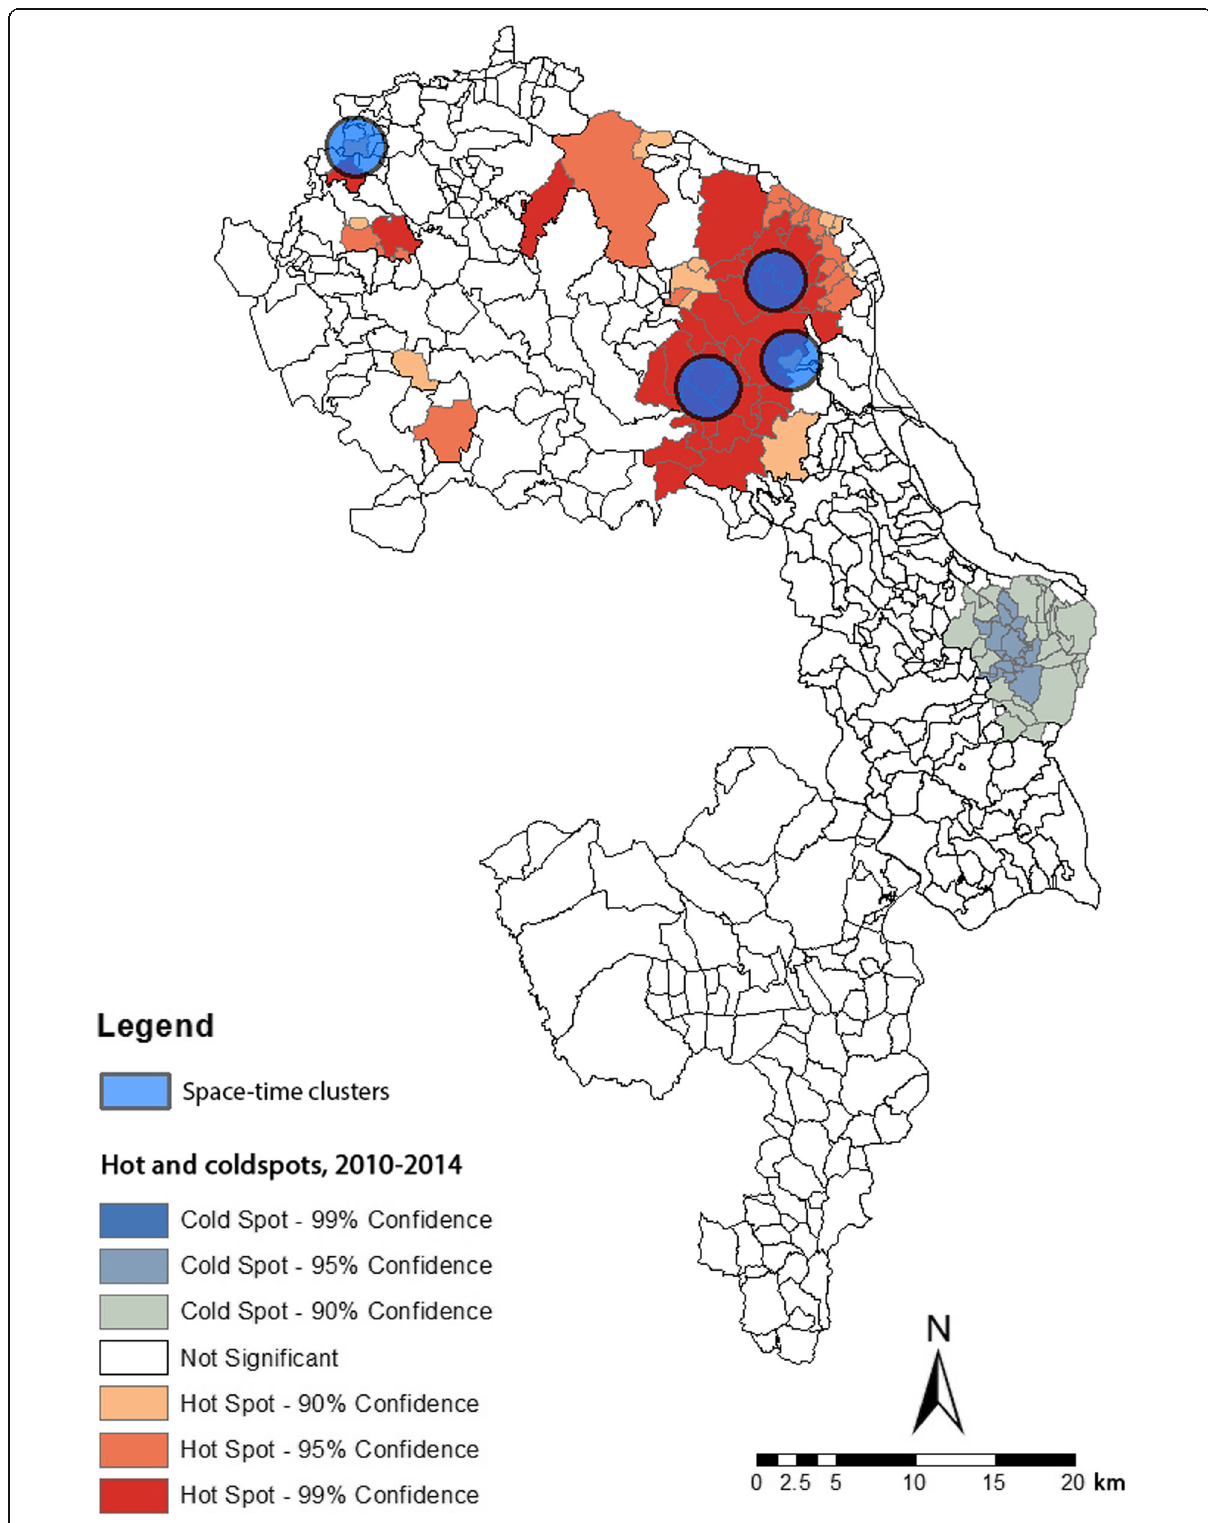
Fig. 3 Space-time clusters (2010 – 2014) with respect to hot and cold spots of VL; circles represent clusters identified by